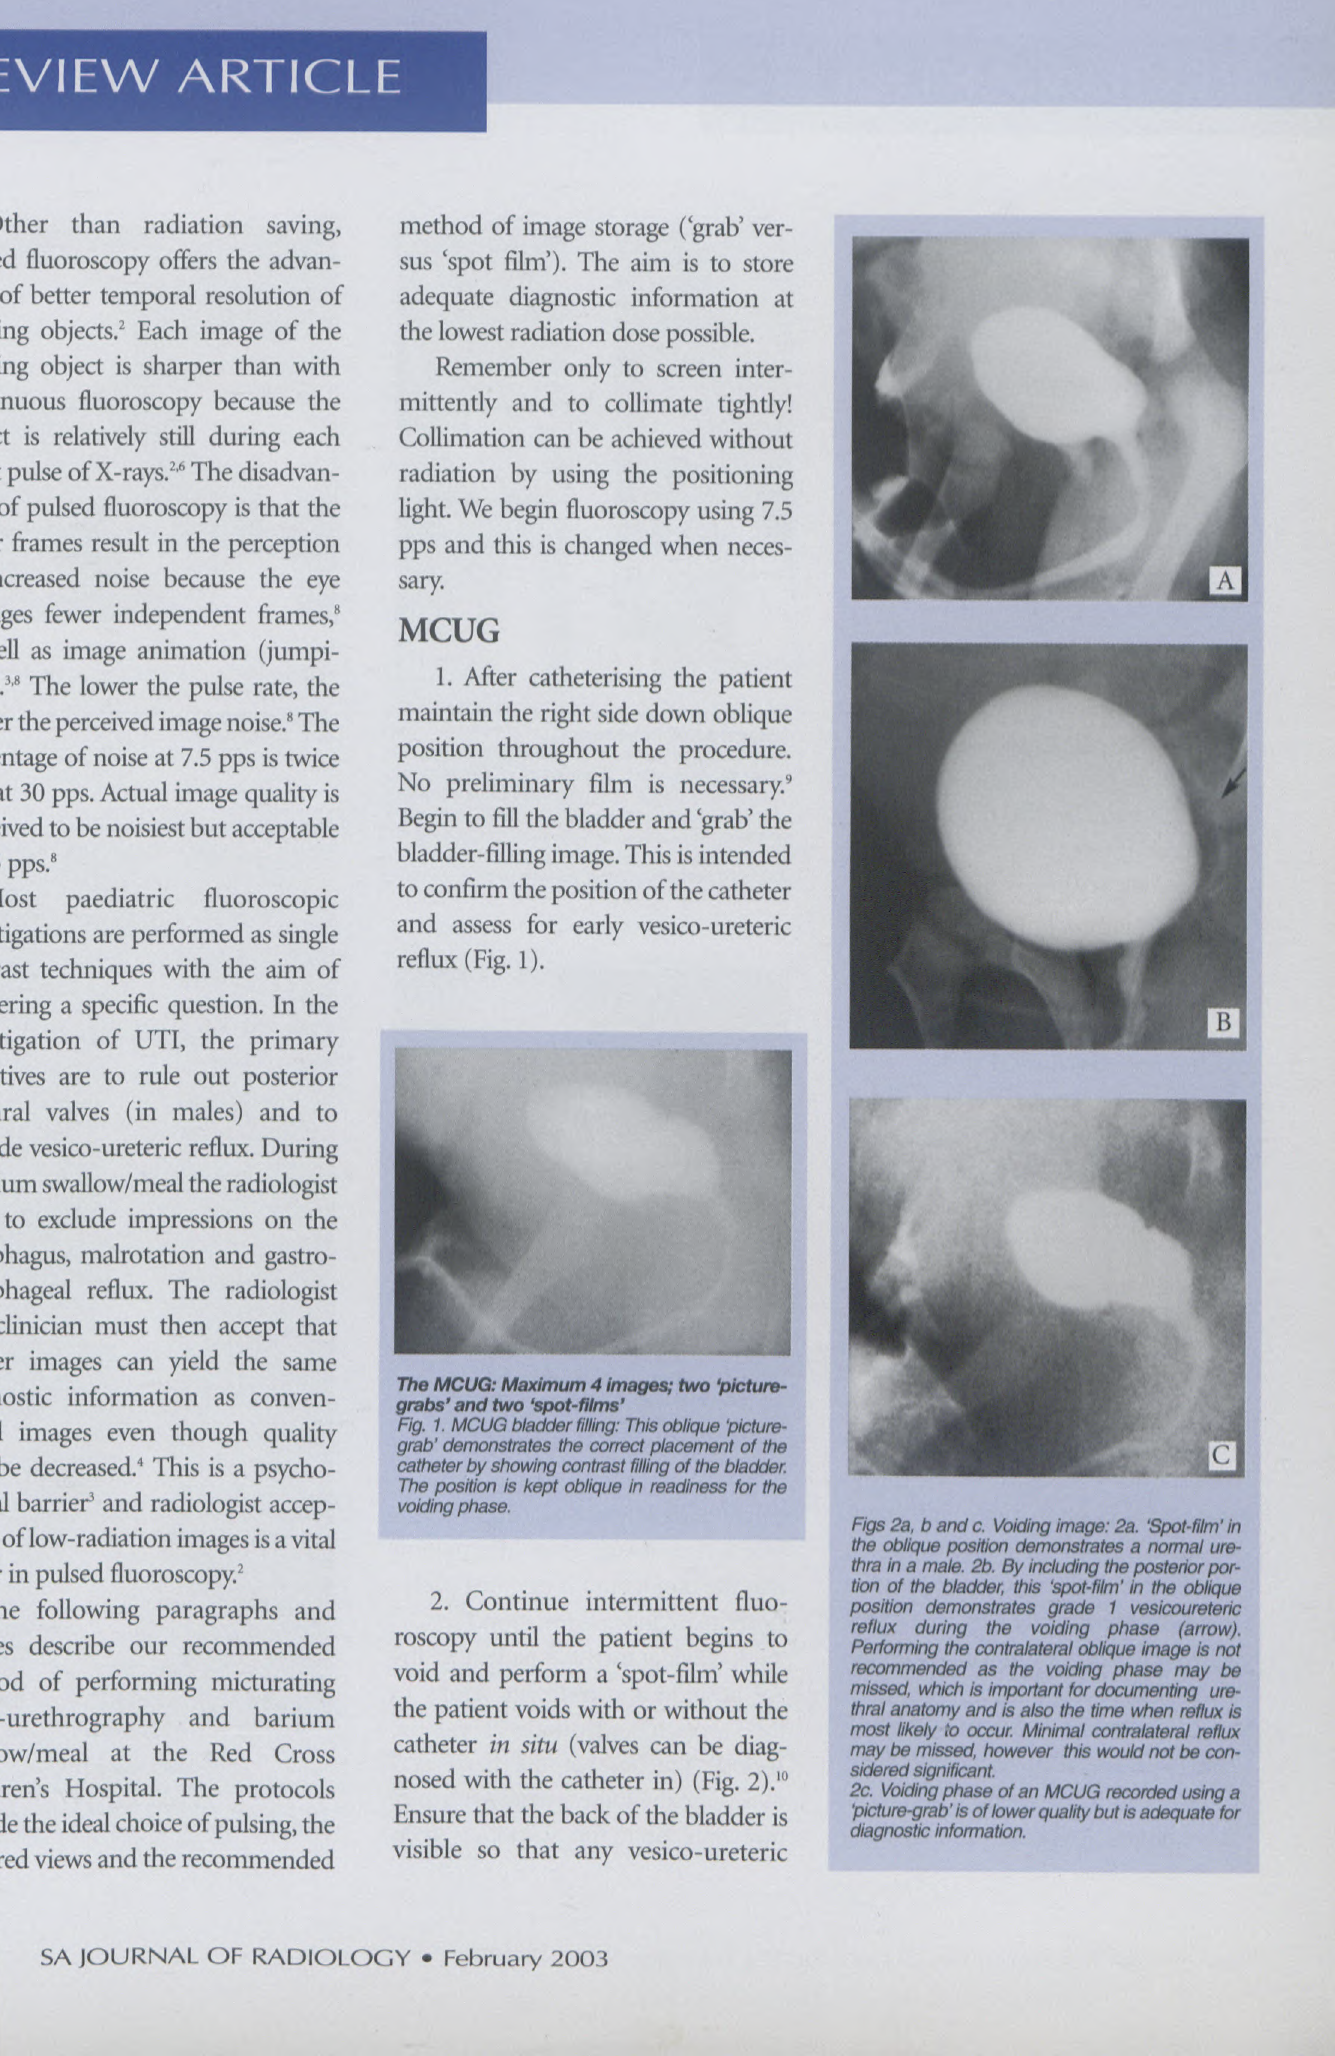
Fig. 1. MCUG bladder filling:Thisoblique 'picture- grab' demonstrates the correct placement of the catheter by showing contrast fiJIingof the bladder. The position is kept oblique In readiness for the voidingphase.